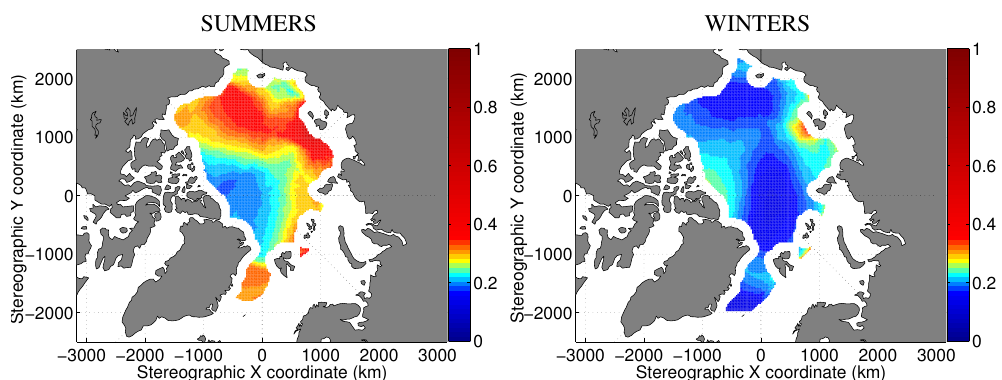
Fig. 9. Spatial pattern of inertial oscillation magnitude within the Arctic Basin in summer (left) and in winter (right). These two fields are computed from the seasonal M dataset. A spatially averaged value of M values, denoted M , is computed following Eq. (10) for each point of a 25km resolution grid. The graphic representation is a linear interpolation of the gridded M values. In order to not represent regions with little data, an M value at a given grid point is plotted only if its associated weight is greater than a minimum value we arbitrarily set to 1000 .